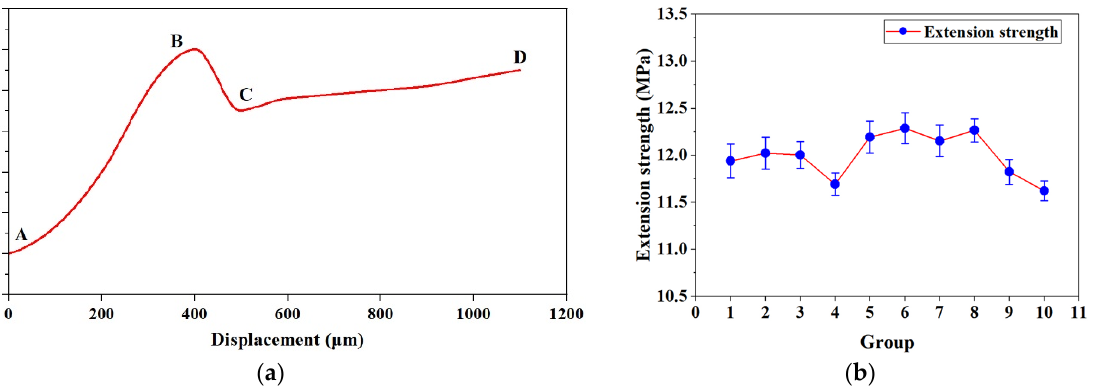
Figure 9. Test findings for the pipe wall bonding strength of the plugging agents: ( a ) the tensile displacement variant; ( b ) each group’s greatest tensile strength.